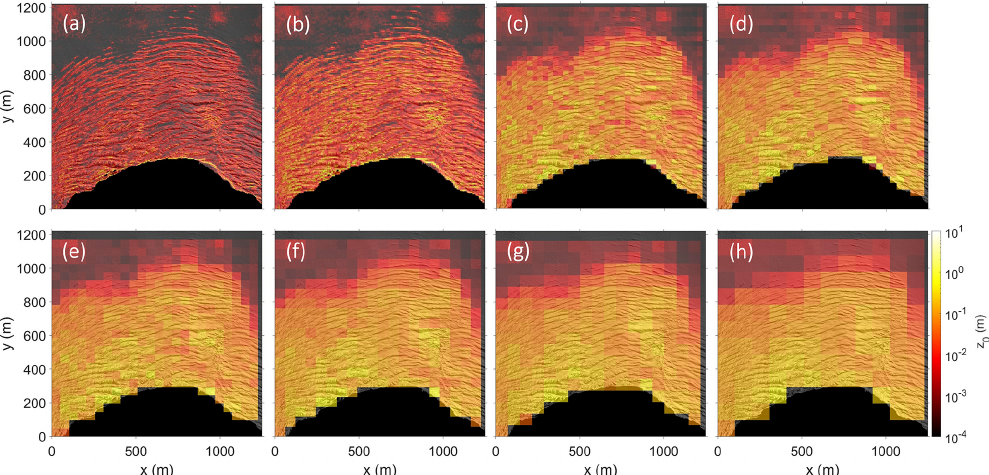
Figure 8. Scale-dependent z 0 values for the Smith model and down-glacier wind direction applied on Fridtjovbreen for sub-grid size resolu-